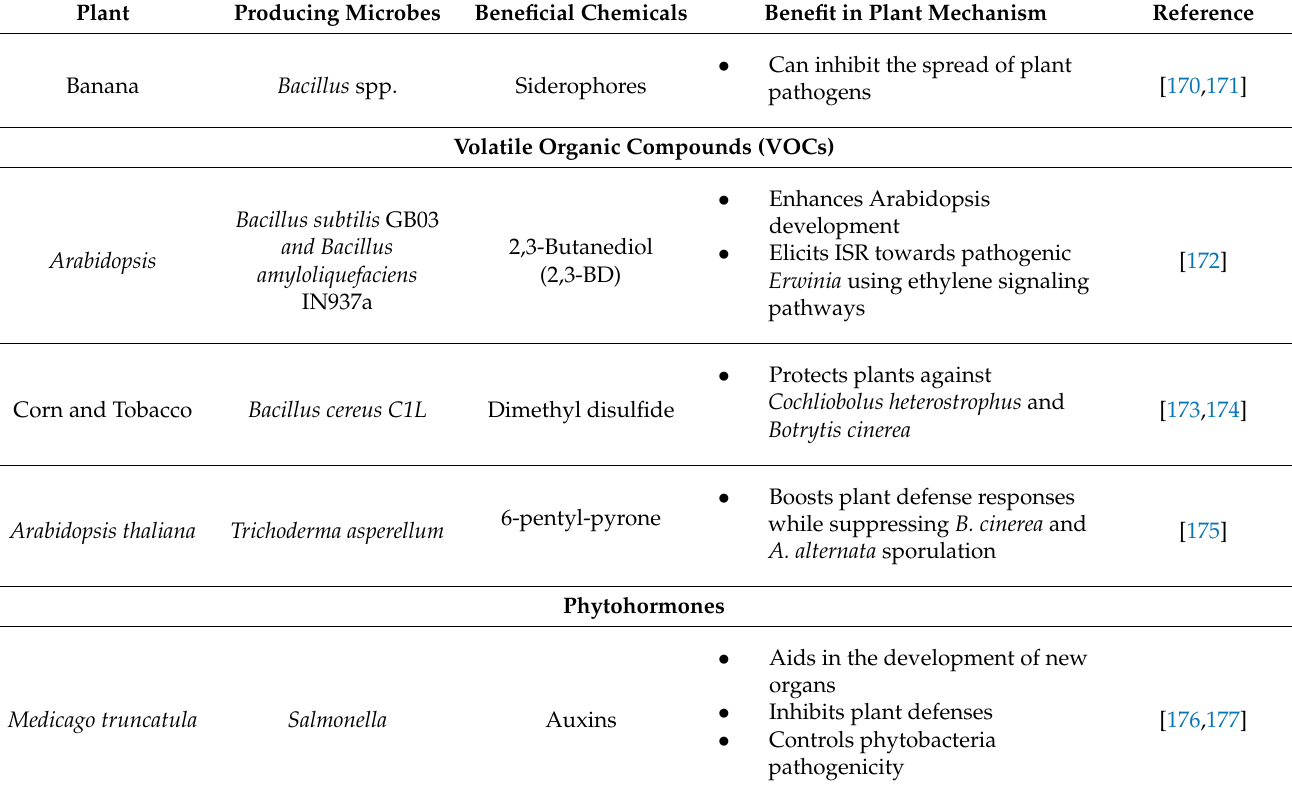
Table 1. The beneficial chemicals exuded by microbes and the benefit to plant defense mechanism.